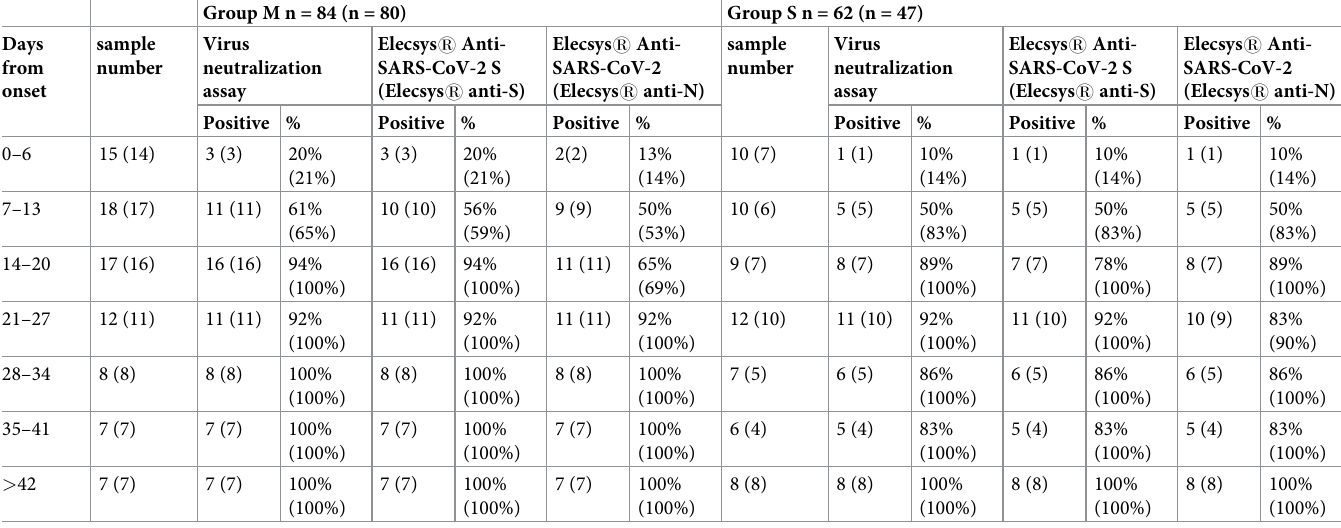
Table 2. Time course of seroprevalence by neutralization assay, Elecsys 1 Anti-SARS-CoV-2 S, and Elecsys 1